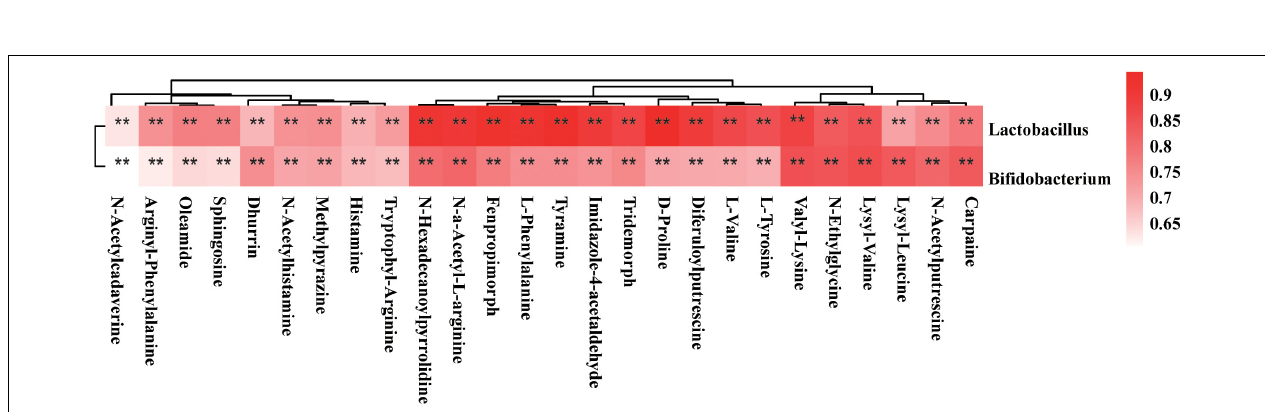
Frontiers in Microbiology |